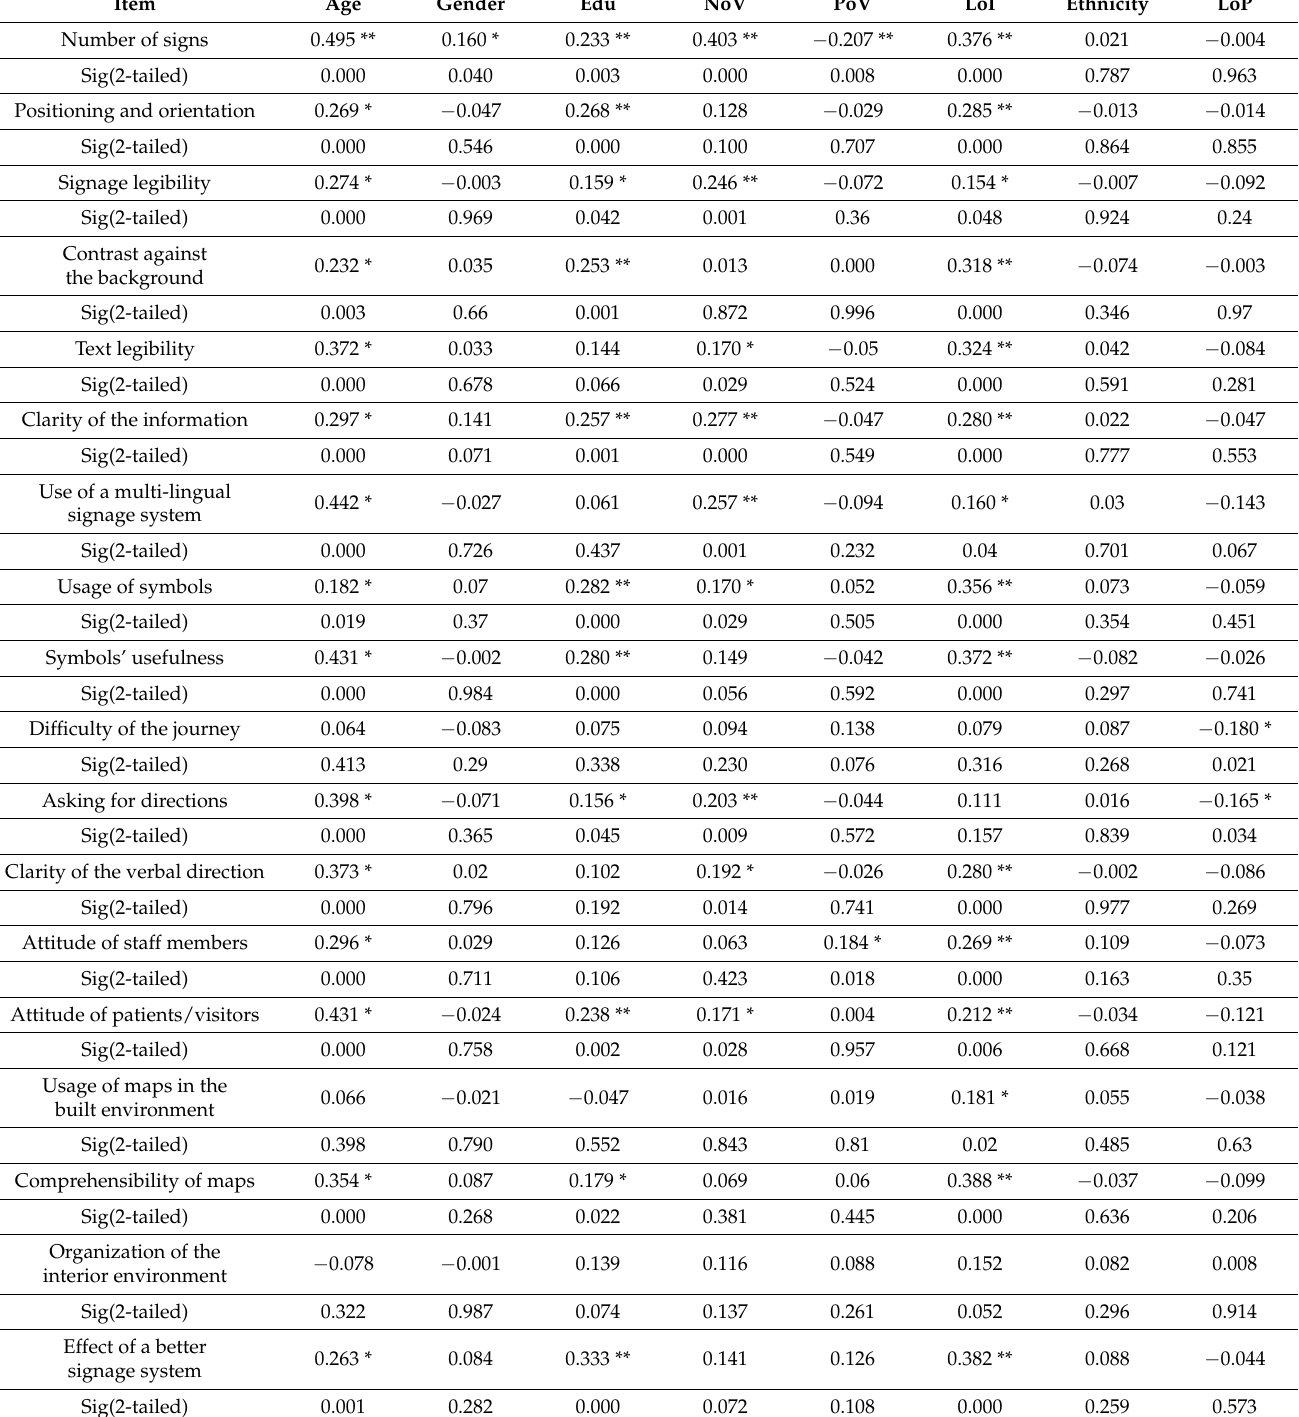
Table 4. Pearson’s correlation test results between the demographic factors and environmental and human-related items tested in the questionnaire